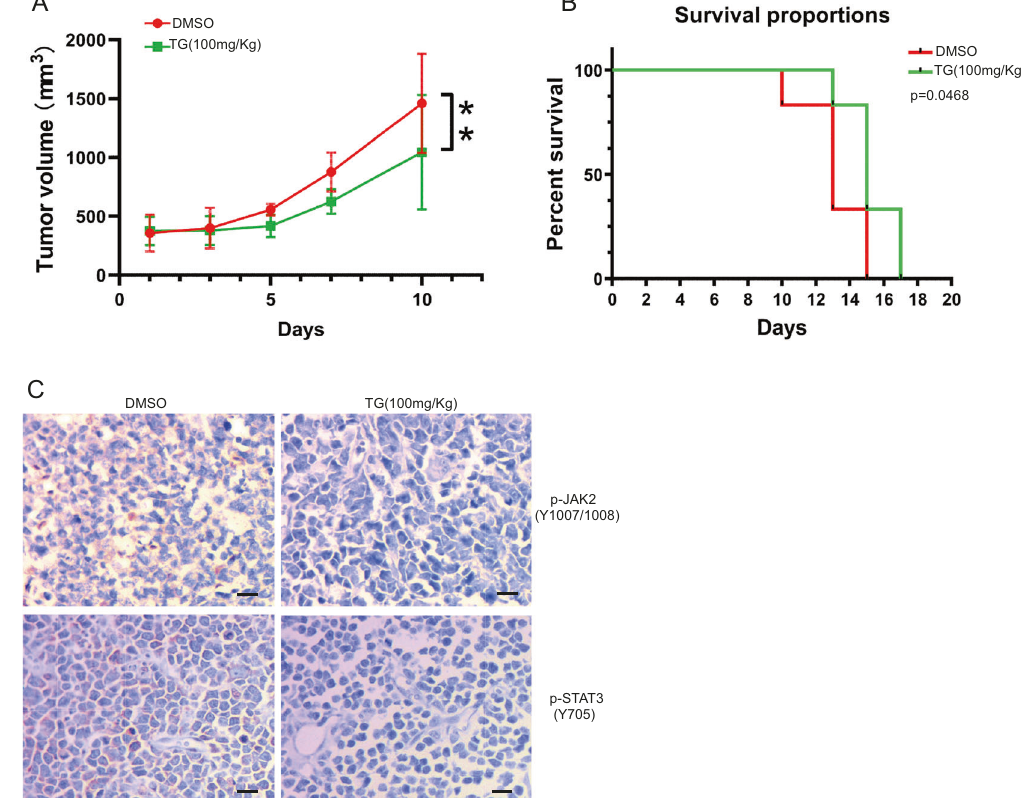
Fig. 6 TG101209 inhibits tumor growth in vivo. The nude mice bearing Ramos-derived tumor xenografts were orally gavaged with TG101209 at doses of 100 mg/kg BID for 7 consecutive days ( n = 6 per group), whereas the control group received DMSO only. A Tumor volume curves showed that TG101209 signi fi cantly suppressed the growth of tumor xenografts. B The Kaplan – Meier method was used for survival analysis, and the log rank test was used to compare the survival rate of the two groups. * p < 0.05. C Expression levels of p-JAK2 and p-STAT3 in the tumors from mice treated with TG101209 or vehicle were detected by IHC staining. Original magni fi cation ×400. Scale bars, 100 μ